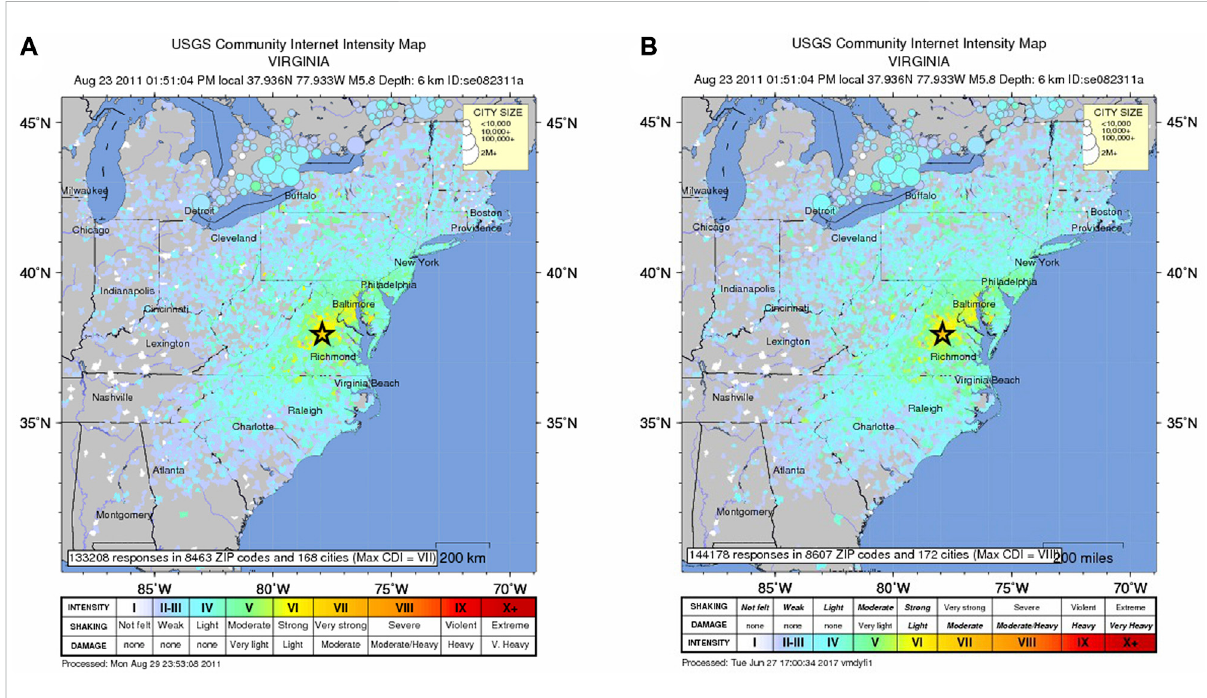
FIGURE 3 (A) Time-stampedmapofDidYouFeelIt?Intensitiesforthe2011Mineral,Virginia,earthquake,generatedon29August2011. (B) Time-stamped map generated on 27 June 2017. Although maps appear to be consistent to fi rst order, close inspection reveals systematic differences. Differences are more clearly evident in plots showing intensities versus distance (Figure 4).